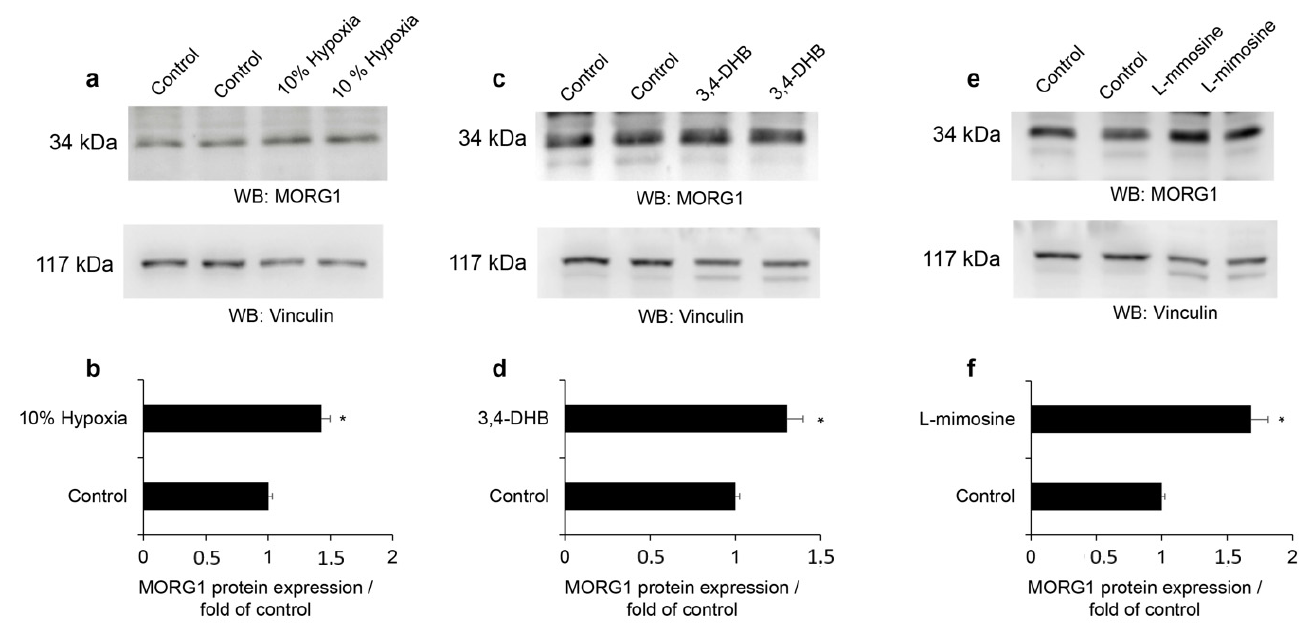
Figure 5. Influence of hypoxia, 3,4-DHB and L-mimosine on human MORG1 protein expression. Cells were left untreated or stimulated for 24 h with 10% hypoxia, 500 µM 3,4-DHB or 500 µM L-mimosine. MORG1 protein expression of was evaluated by Western blot analysis. The relative expression was normalized to vinculin expression and is graphically presented as a fold expression relative to untreated control, which was set as 1. ( a ) Analyses of the MORG1 protein expression in HEK 293 cells exposed to 10% hypoxia. Representative images are shown. ( b ) The graph represents the densitometry analyses of the MORG1 protein expression using Image J software. N = 4/4. * p < 0.05 vs. control. ( c ) Western blots for MORG1 protein in cells treated with 500 µM 3,4-DHB. Representative images are shown. ( d ) The graph represents the densitometry measurements of the MORG1 protein expression using Image J software. N = 4/4. * p < 0.05 vs. control. ( e ) Expression of MORG1 protein in cells treated with 500 µM L-mimosine. Representative images are shown. ( f ) The graph represents the densitometry measurements of the MORG1 protein expression in L-mimosine treated cells relative to control. N = 4/4. * p < 0.05 vs. control.